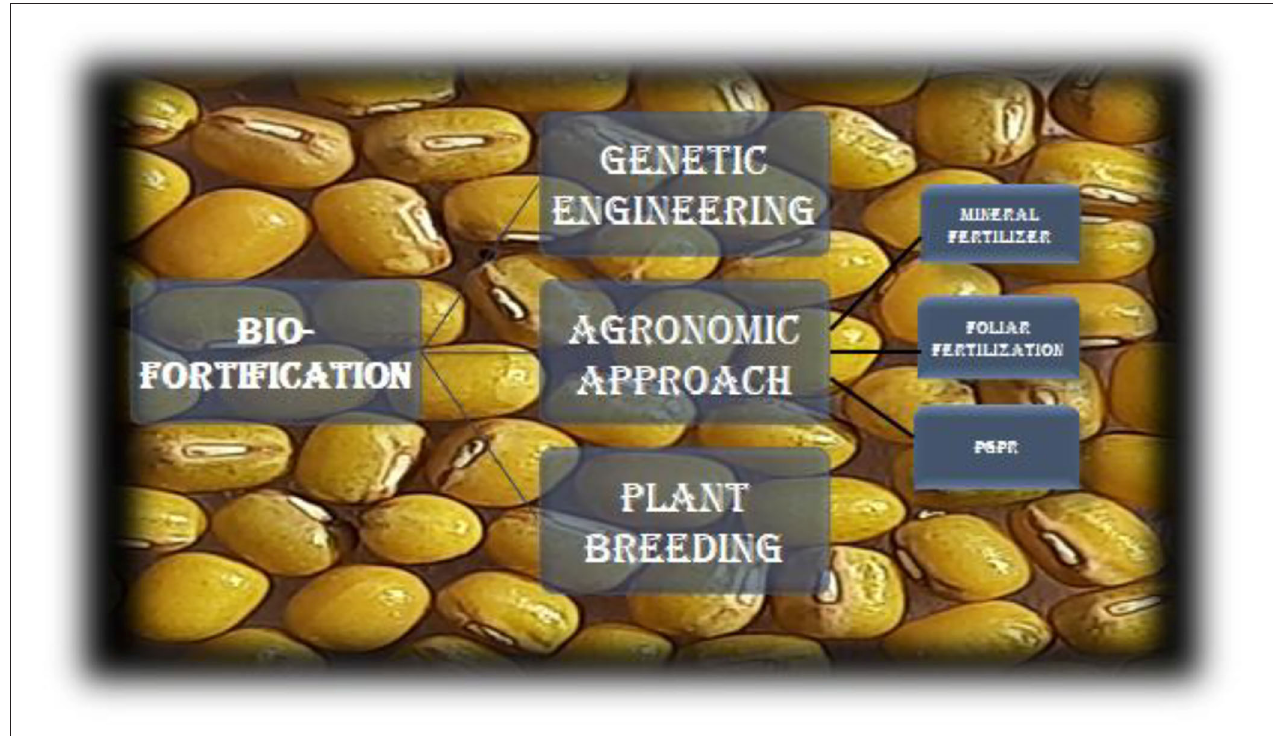
FIGURE 3 | Approaches of biofortification for improvement of nutritional